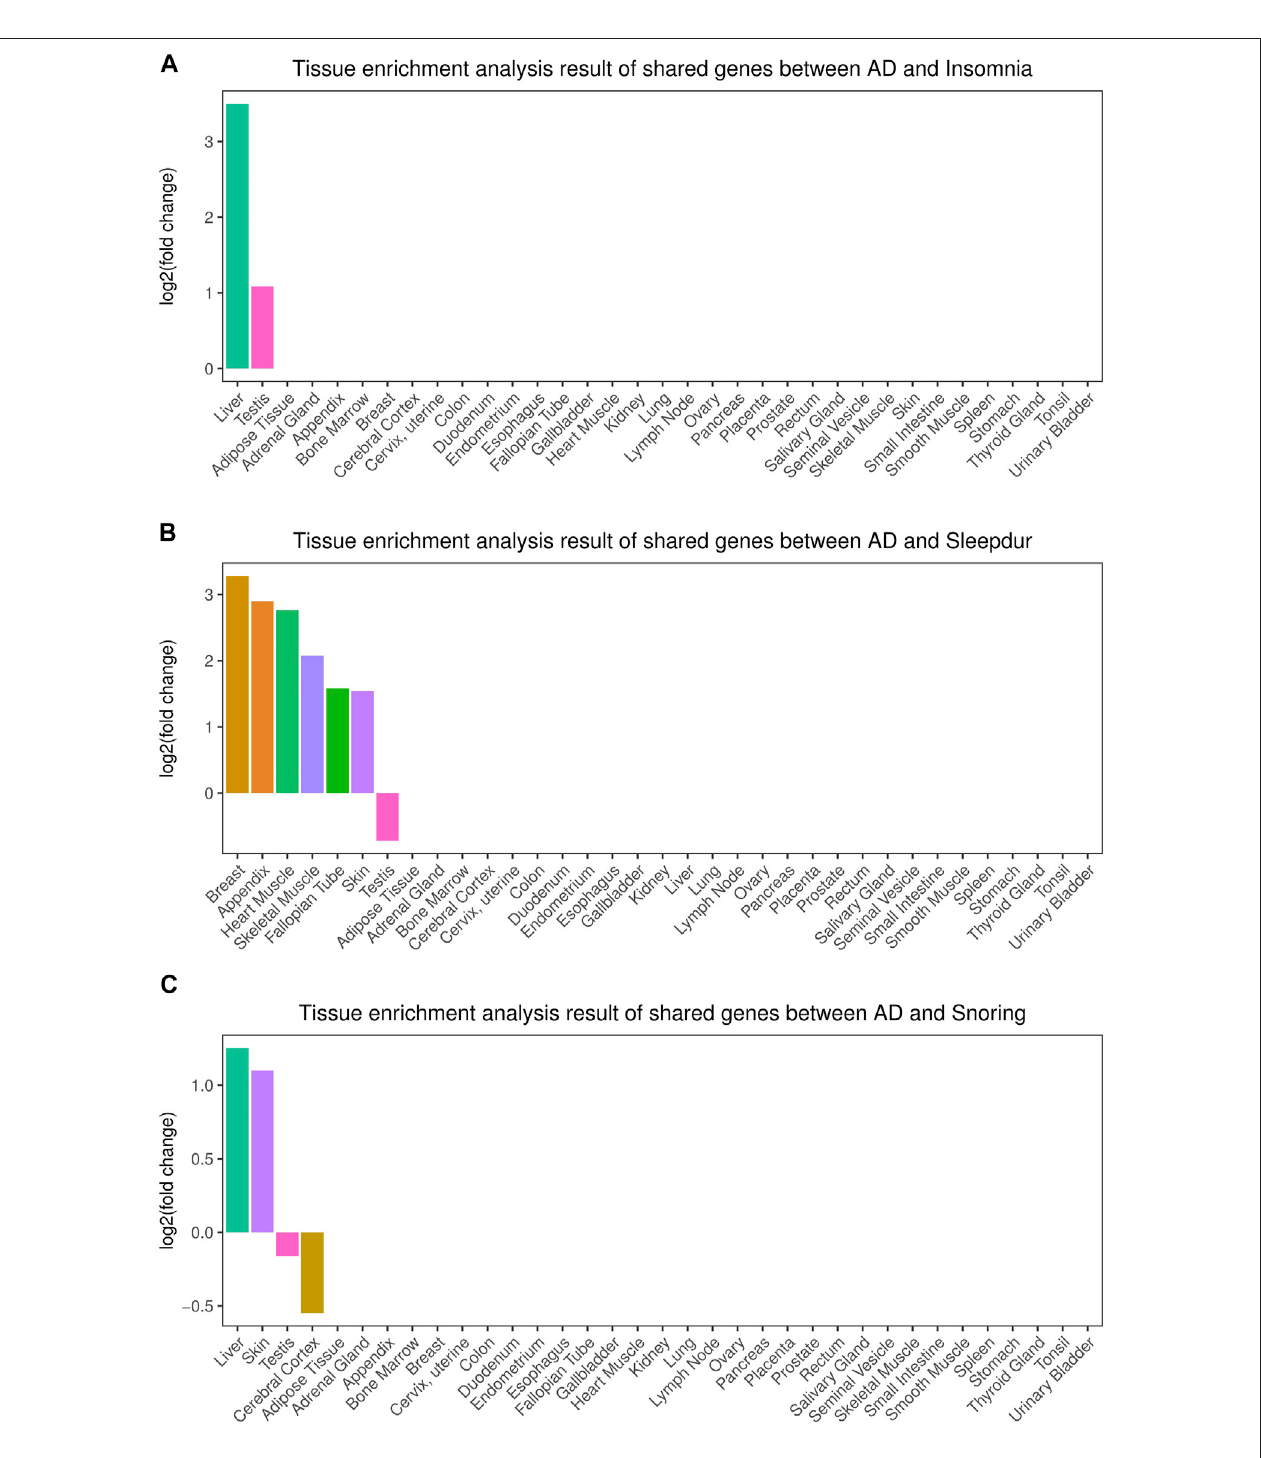
FIGURE 3 | Tissue enrichment for the consensus set. (A) Tissue enrichment analysis results of shared genes between AD and insomnia; (B) Tissue enrichment analysis results of shared genes between AD and sleep duration. (C) Tissue enrichment analysis results of shared genes between AD and snoring. The vertical axis illustrates the logarithm of fold change after the Benjamini – Hochberg correction. The horizontal axis illustrates 35 independent tissue types.